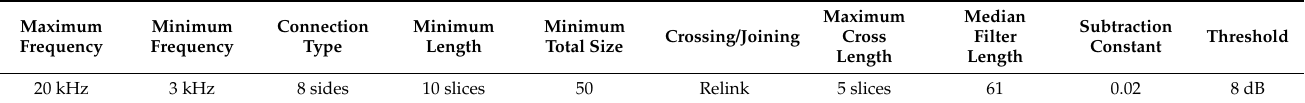
Table 1. The whistle detector settings that were used in the present study to detect bottlenose dolphin whistles. Adapted from Rankin et al. [15]. For definitions of the column headings please see Appendix A. For additional details on what each setting does see Gillespie et al. [13].